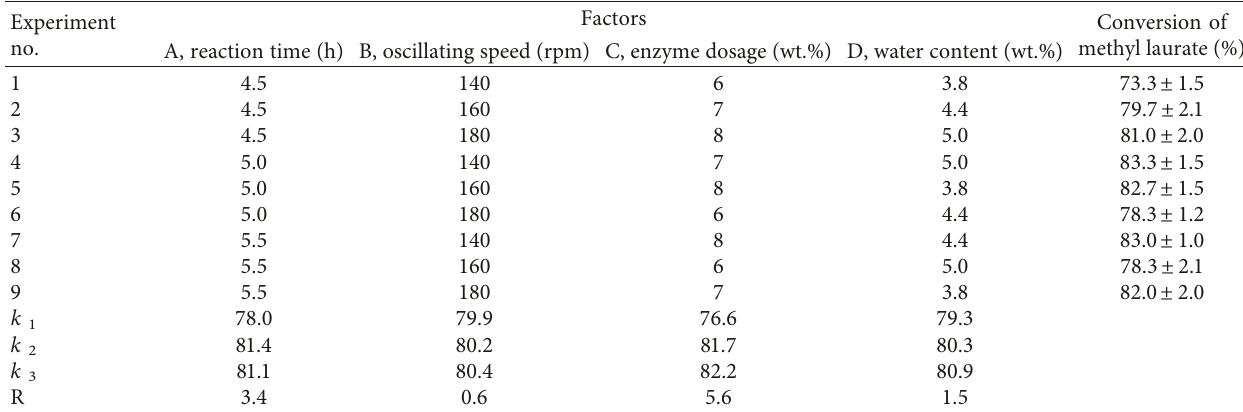
Table 2: Analysis of L